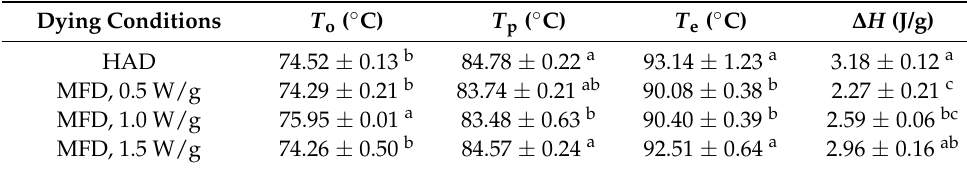
Table 4. Thermal properties of dried yam flours subjected to various drying methods. Dying Conditions